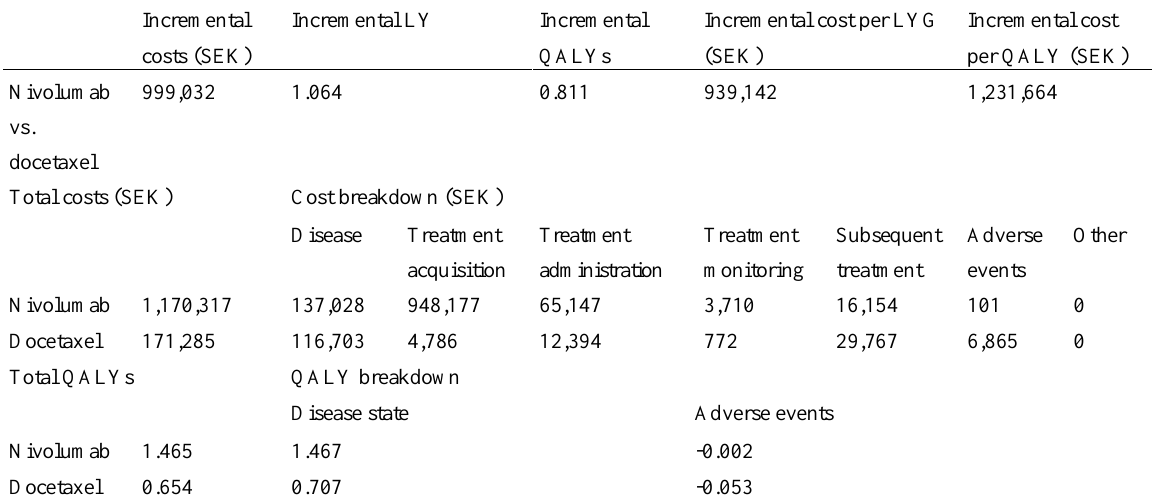
Table 4: Base-case cost-effectiveness results (non-squamous analysis; CheckMate